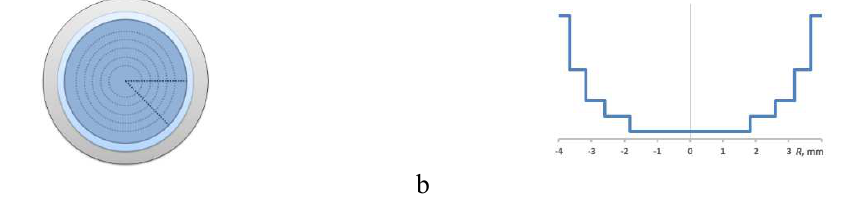
Figure 2: Geometrical model (a) and aggregated material worth radial distribution